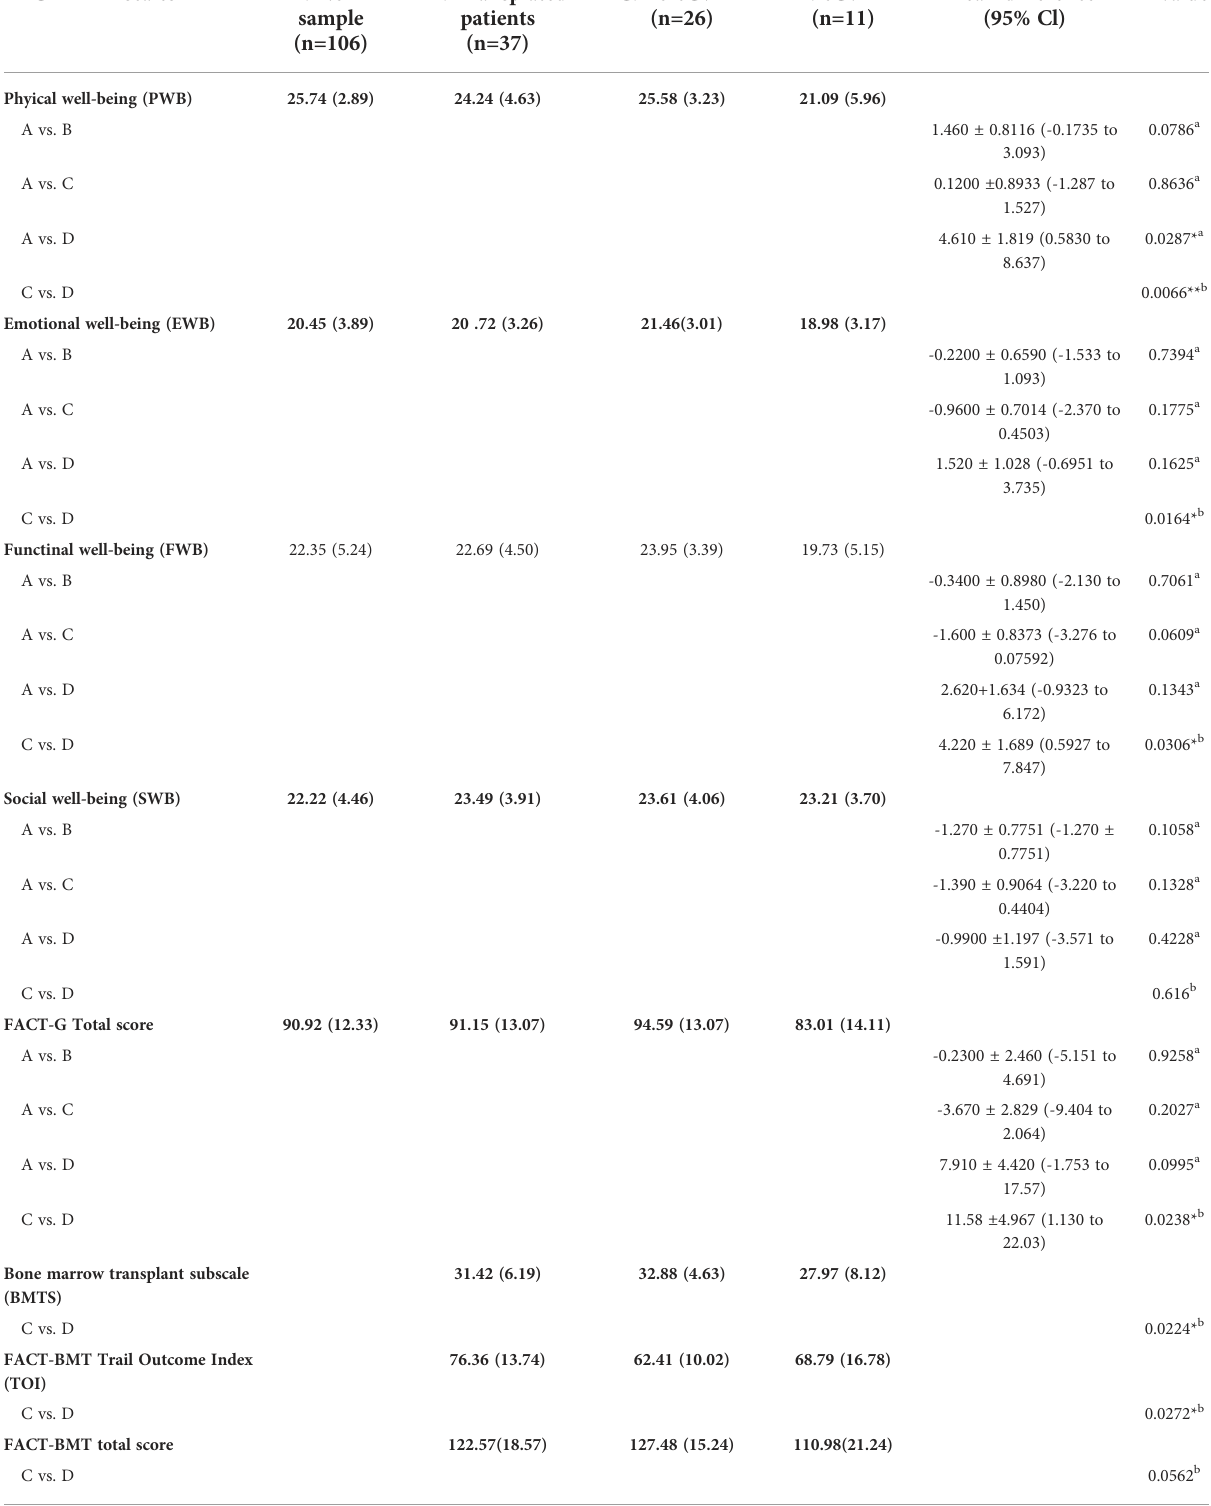
TABLE 3 Scores as reported by the FACT-BMT questionnaire and level of signi fi cant differences in participants with and without GvHD. and in comparison to the norm sample. FACT-BMT